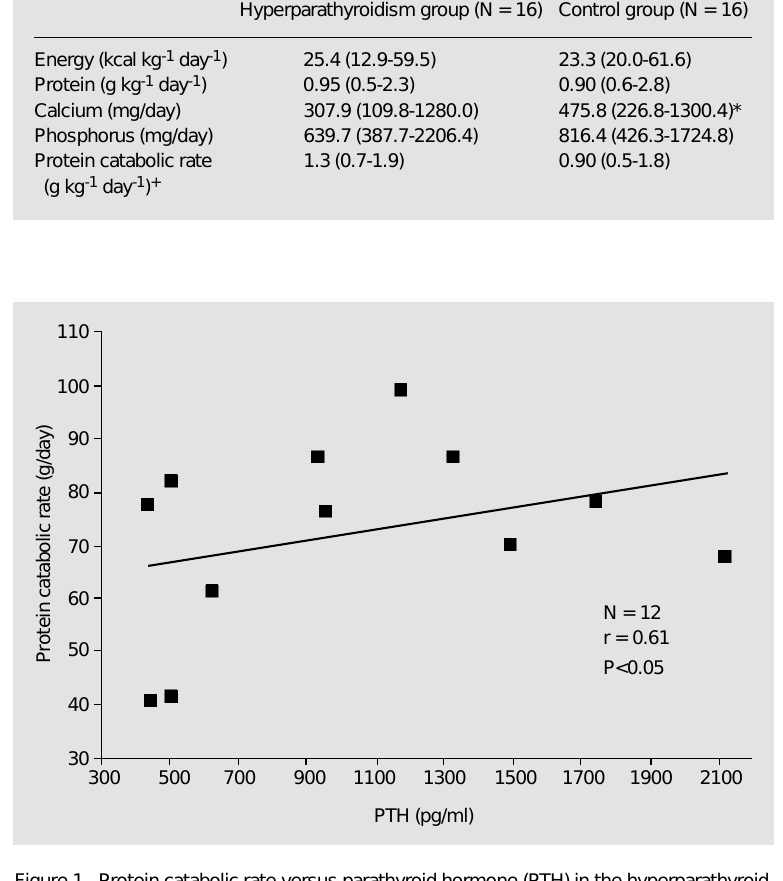
Figure 1 - Protein catabolic rate versus parathyroid hormone (PTH) in the hyperparathyroid- ism